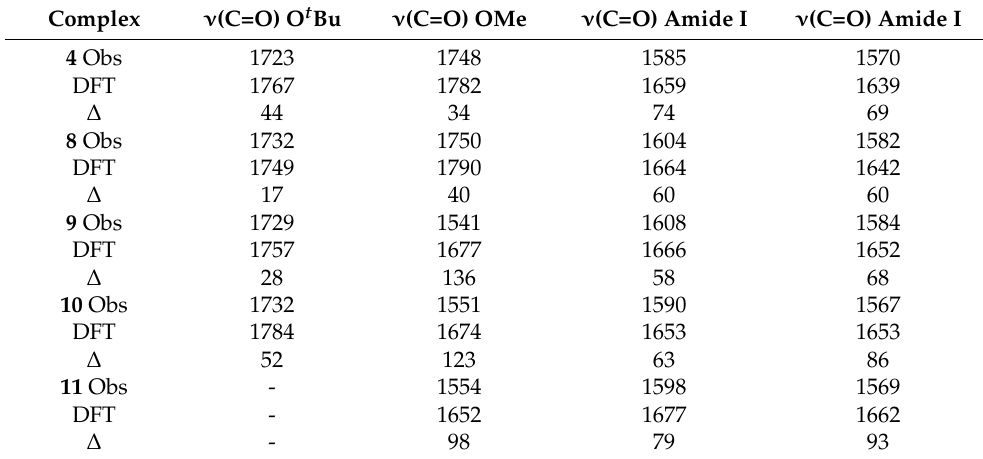
Table 6. Comparative frequencies (cm − 1 ) for ν (C=O) vibrational modes observed versus DFT- calculated for 4 , 8 – 11 . The ∆ values show the deviation between observed and calculated DFT